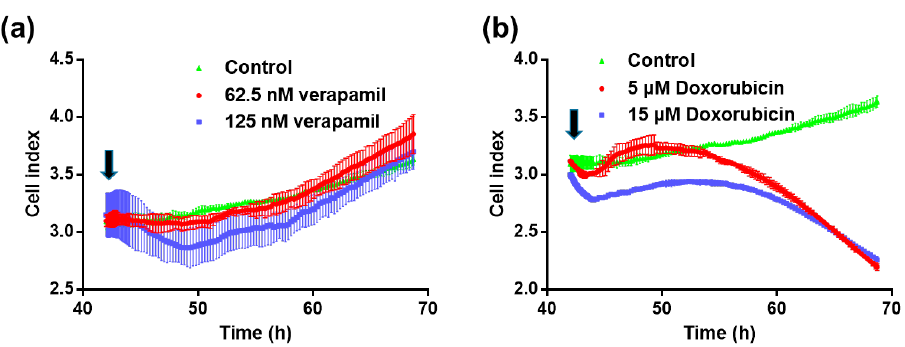
Figure 3. Heart-on-a-chip for doxorubicin test. ( a ) The beating signals before and after the doxorubicin with different concentrations are administered on the cardiomyocytes; ( b ) Statistical beating rate within 60 min in the presence of doxorubicin; ( c ) Statistical beating rate within 60 min in the presence of doxorubicin.